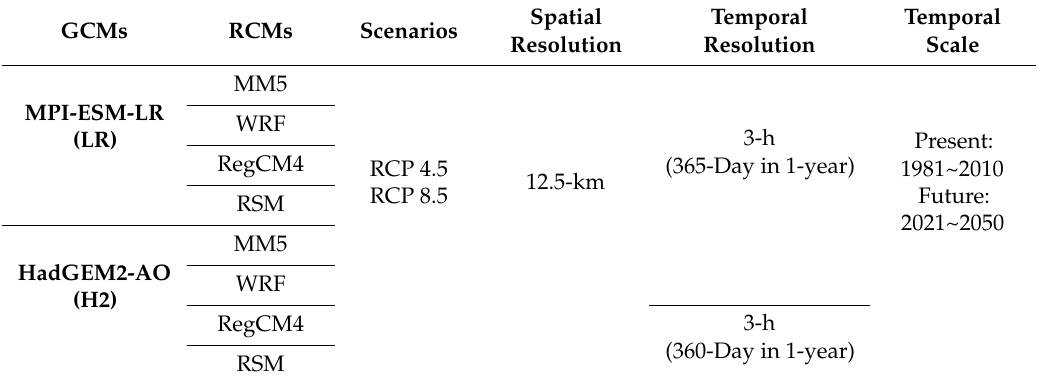
Table 1. Information of future climate models